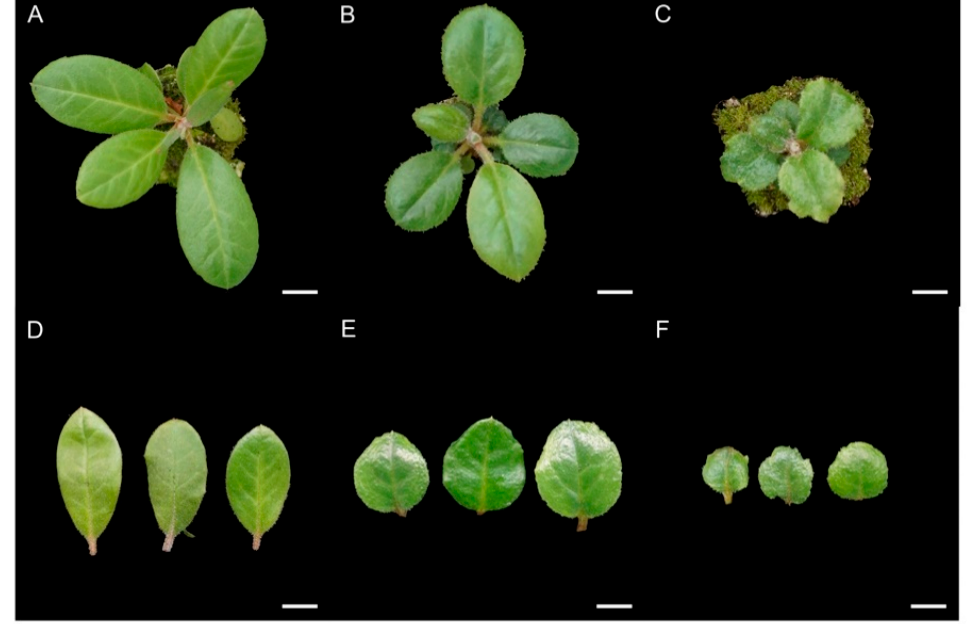
Figure 3. Comparison of morphological difference between 6-months old polyploid and diploid R. fortunei plants. ( A and D ), a diploid plant and its leaves; ( B and E ), a tetraploid plant and its leaves; ( C and F ), an octoploid plant and its leaves. Scale bar = 1 cm. Table 3. Leaf morphological characteristics of polyploid and diploid R. fortunei plants.